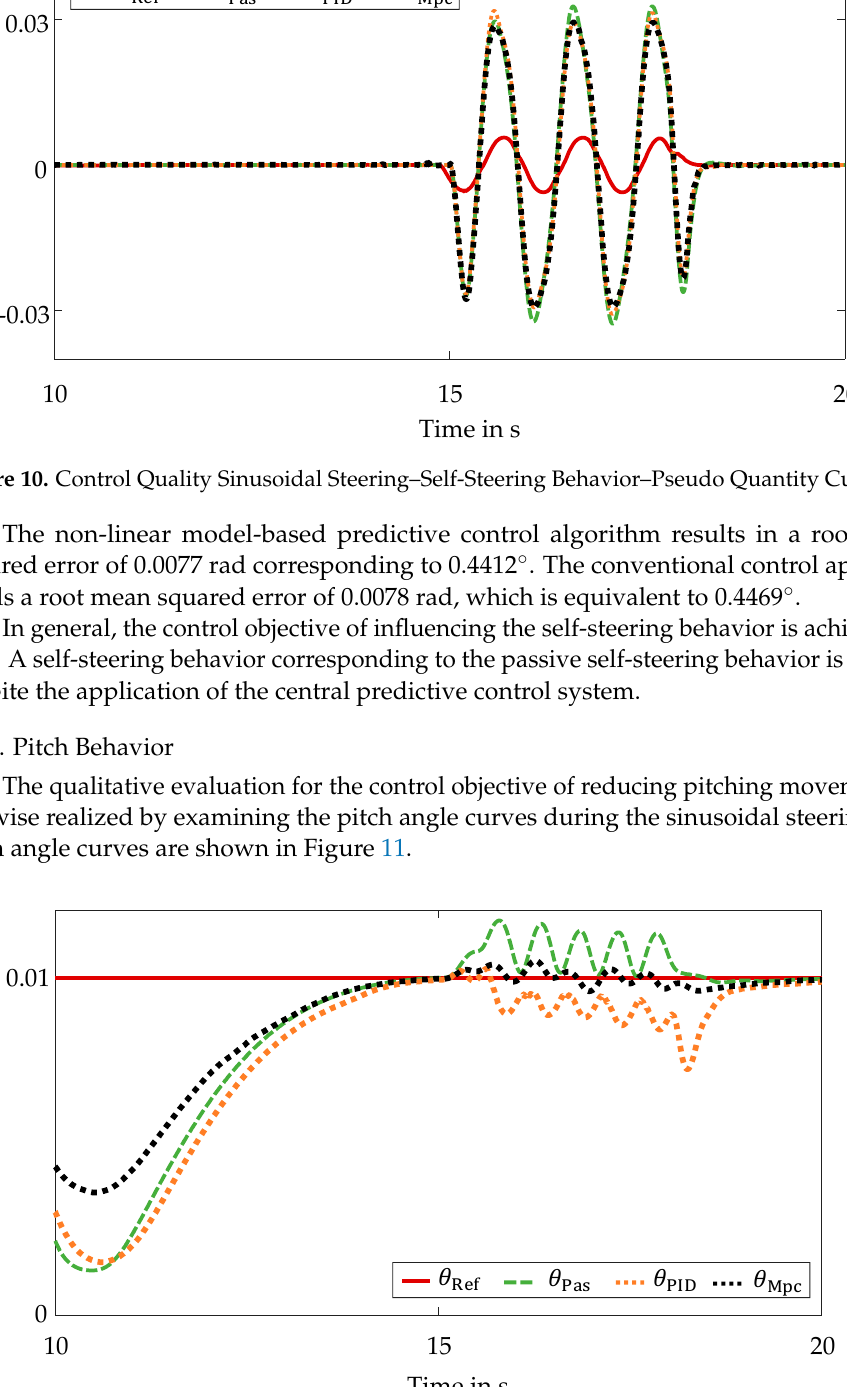
the conventional control approach, though slightly larger deviations from the reference variable are present.